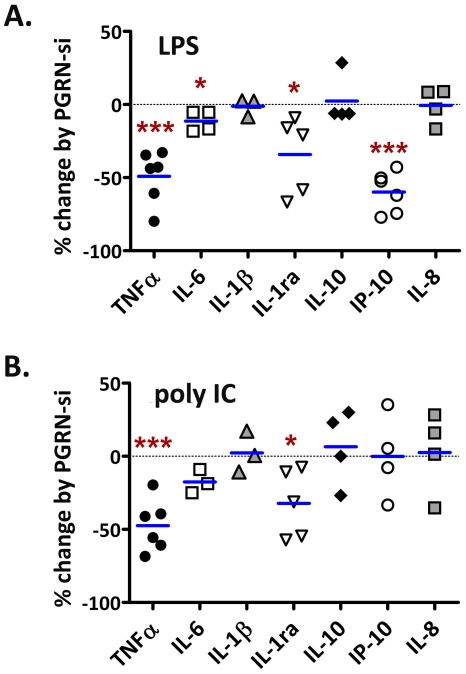
PGRN modulates TLR3/4-mediated cytokine production (pooled data from multiple cases).Microglia were transfected with control or PGRN siRNA for 3 days, then further treated with LPS (A) or poly IC (B) for additional 24 h, then cytokines were measured ELISA as shown in Figure 8. Data are then expressed as % change by PGRN siRNA as calculated by 100×(PGRN siRNA/control siRNA - 1). Zero (dotted line) marks no change. Results shown are from multiple microglial cases with each symbol representing a different case. The data show that PGRN siRNA reduced the amount of microglial TNFα, IL-6, IL-1ra and IP-10 induced by LPS, and TNFα and IL-1ra induced by poly IC. * p<0.05, ** p<0.01, *** p<0.001.